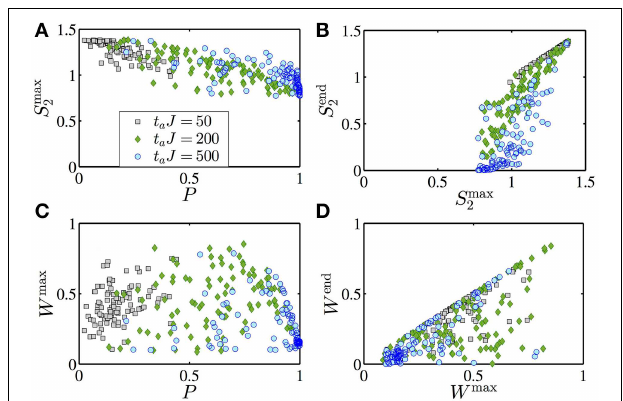
FIGURE 5 | Maximal entanglement reached during the optimization algorithm in closed systems of N = 16 sites for different annealing times t a J = 50 (black squares), 200 (green diamonds) and 500 (blue lozenges). (A) Entanglement entropy between two sites and the rest of the system, maximized over all pairs of sites, and (C) optimized entanglement witness, both as a function of success probability. The measured entanglement occupies a broad range, making it difficult to find correlations to the success probability. The maximal entanglement entropy shows only a slight anticorrelation with the success probability P , which is inherited from the bound Equation (15) and the fact that the final-state entropy for unsuccessful sweeps remains close to the maximal one (B) . This behavior is less prominent for the entanglement witness (D)